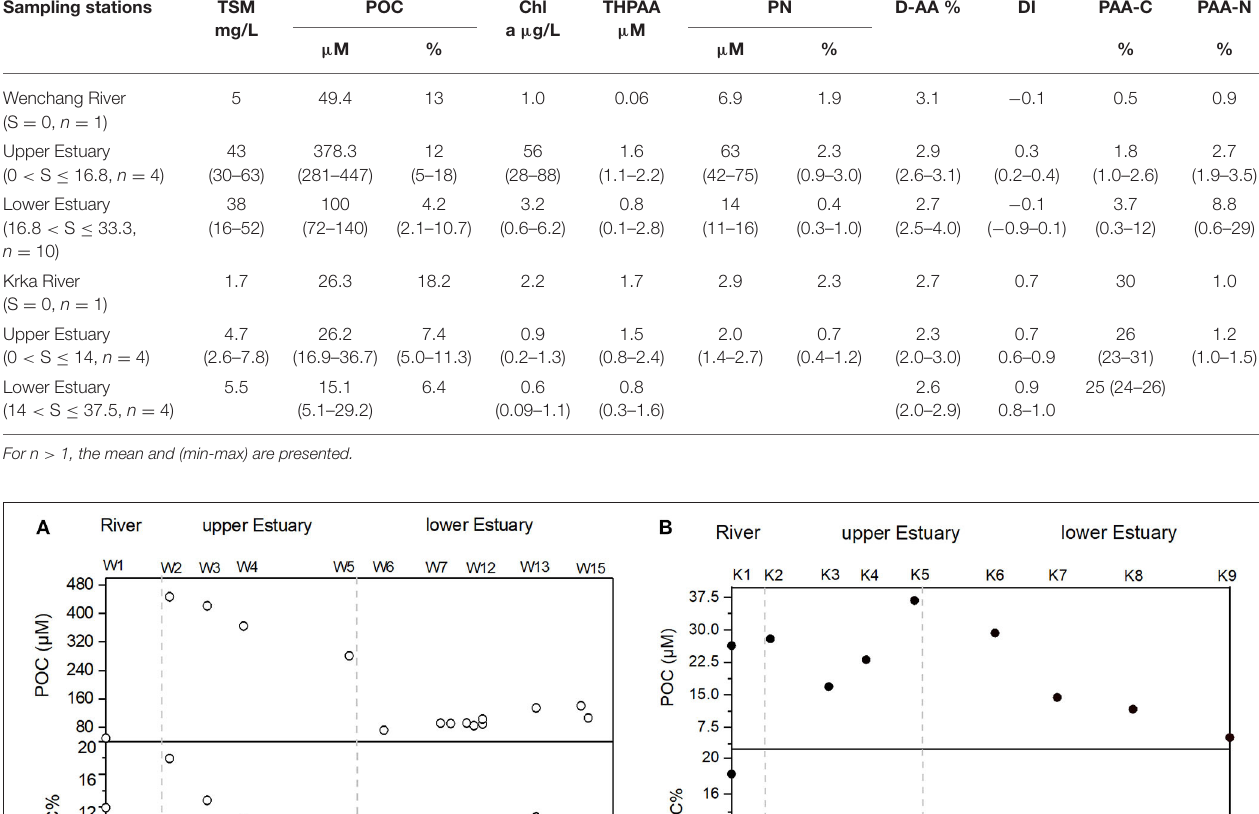
TABLE 2 | Total suspended matter (TSM) and Particulate OM in surface waters of the WRE and the KRE. Sampling